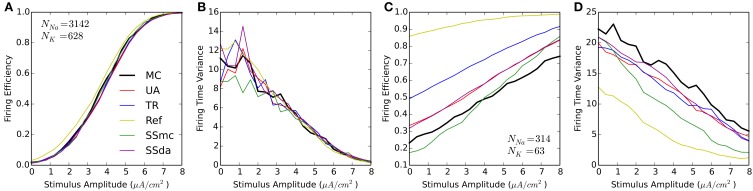
Responses of the Schmidt-Hieber and Bischofberger (SB) single compartment model to a 1-ms stimulus pulse. (A,B) Firing efficiency (A) and Variance of the firing time (B) for the stochastic model with a membrane area of 314.2 μm2 and the number of channels indicated. 2000 sweeps were simulated and the Firing Efficiency is the fraction of sweeps in which an action potential was elicited. (C,D) Same as (A,B) with a membrane area of 31.4 μm2.